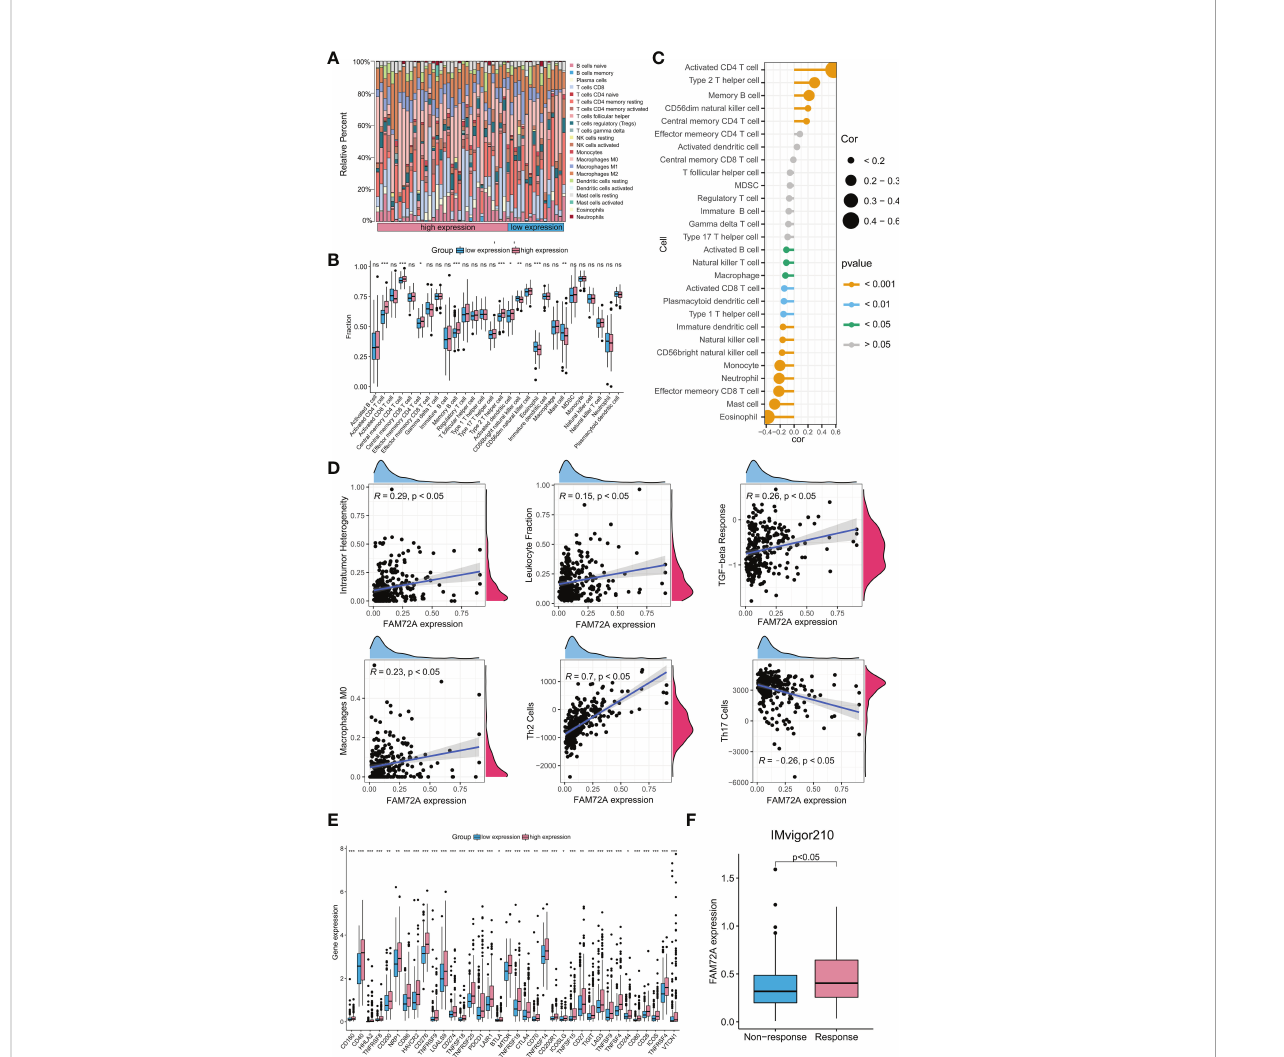
FIGURE 8 Immune-related analysis of FAM72A in HCC. (A) The difference in the abundance of 29 immune cell types between the high and low FAM72A expression groups. (B) Correlation between FAM72A mRNA expression and immune cell in fi ltration. Statistical analyses were performed using the Wilcoxon test. (C) The proportions of 22 tumor-in fi ltrating immune cell types in the high and low FAM72A expression groups were evaluated using the CIBERSOFT algorithm. Statistical analyses were performed using the Spearman correlation test. (D) Correlation between FAM72A mRNA expression and immune scores. Statistical analyses were performed using the Spearman correlation test. (E) The differences in expression of 36 immune checkpoints between the high and low FAM72A expression groups. Statistical analyses were performed using the Wilcoxon test. (F) The relationship between FAM72A expression and the ef fi ciency of immunotherapy in the IMvigor210 cohort. Statistical analyses were performed using the Wilcoxon test. HCC, hepatocellular carcinoma. *p < 0.05, **p < 0.01, and ***p <